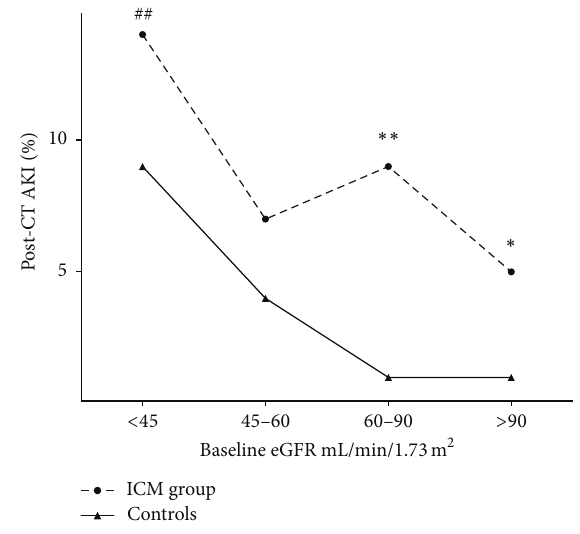
Figure 1: Percentage of patients developing post-CT AKI in the ICM group compared to controls. Using Fisher’s exact test: ∗ 𝑃 < 0.05 and ∗∗ 𝑃 < 0.001 , comparing the ICM group versus controls and ## 𝑃 < 0.005 comparing to patients with a baseline GFR > 90 mL/min/1.73m 2